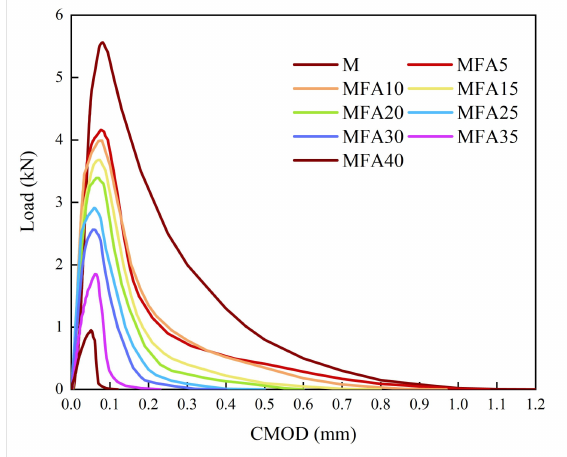
Figure 11. Load—CMOD curves.